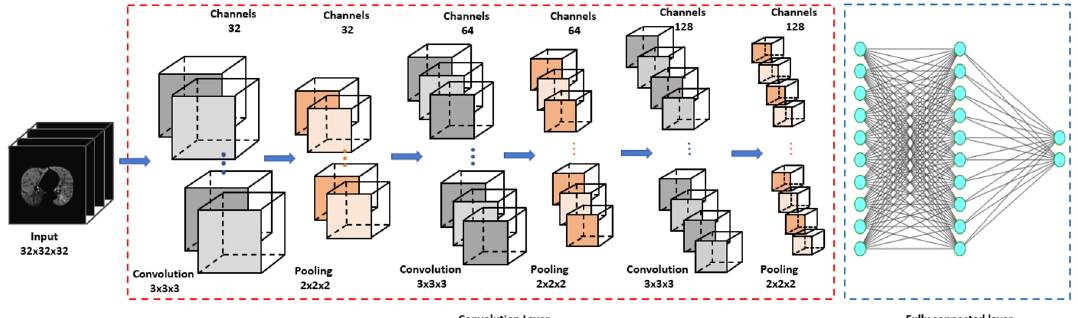
Figure 2. Architecture of the 3D-CNN model. This figure was generated with Microsoft PowerPoint 2010 (version 13328.20292; https ://www.micro soft.com).